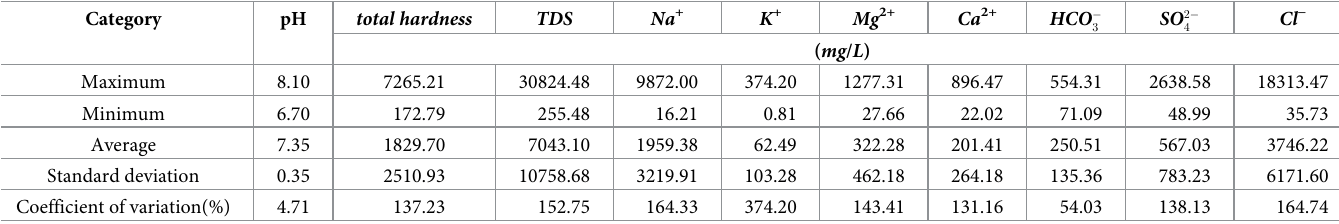
Table 4. Hydrochemical indicators in AREA